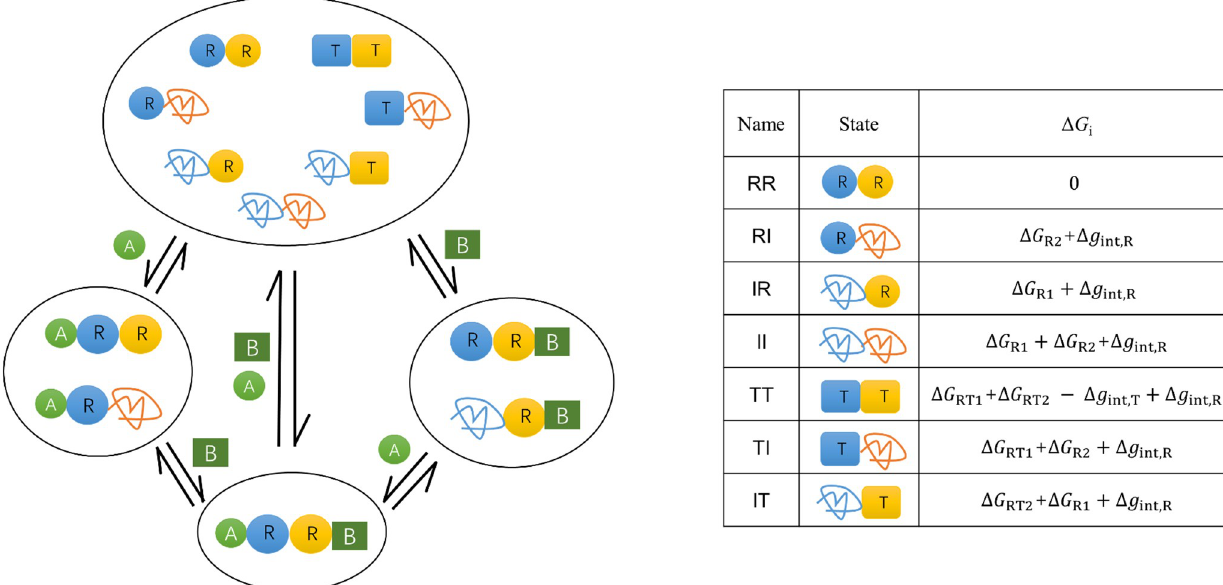
Fig 2. Schematic representation of the proposed comprehensive ensemble model, which compounds the assumptions of both the MWC and the EAM models. Each domain (blue and yellow) can be in R (Relaxed), T (Tensed) and I (Disordered) state. R and T are incompatible as assumed in the MWC model, and thus there are now seven possible combinations for protein states. Similar to the EAM model, the disordered I state of a domain does not have any interface interaction with the adjacent domain, and it does not bind to any ligand or substrate due to the lack of ordered structures. The expressions for the free energy ( Δ G ) of each state (relative to RR as the reference state as that in the EAM model) were listed in the absence of ligand and substrate. Δ G R1 i and Δ G R2 are the free energy of unfolding the R state of each domain, and Δ g int,R and Δ g int,T are the free energy of breaking the interface interactions in RR and TT, respectively, which were defined in a manner similar to the EAM model. Δ G RT1 and Δ G RT2 are the free-energy of the R-T transition for each domain. A is allosteric regulation ligand binding to one (blue) domain, and B is the substrate to the other (yellow) domain. A and B are different molecules, i.e., we consider the heterotropic allosteric effect. To enable both positive and negative allosteric effect for ordered proteins, we consider two binding modes for A: it can only bind to the R state of the blue domain (A-R binding mode) (as depicted here), or can only bind to the T state of the blue domain (A-T binding mode). B always binds only to the R state of the yellow domain.